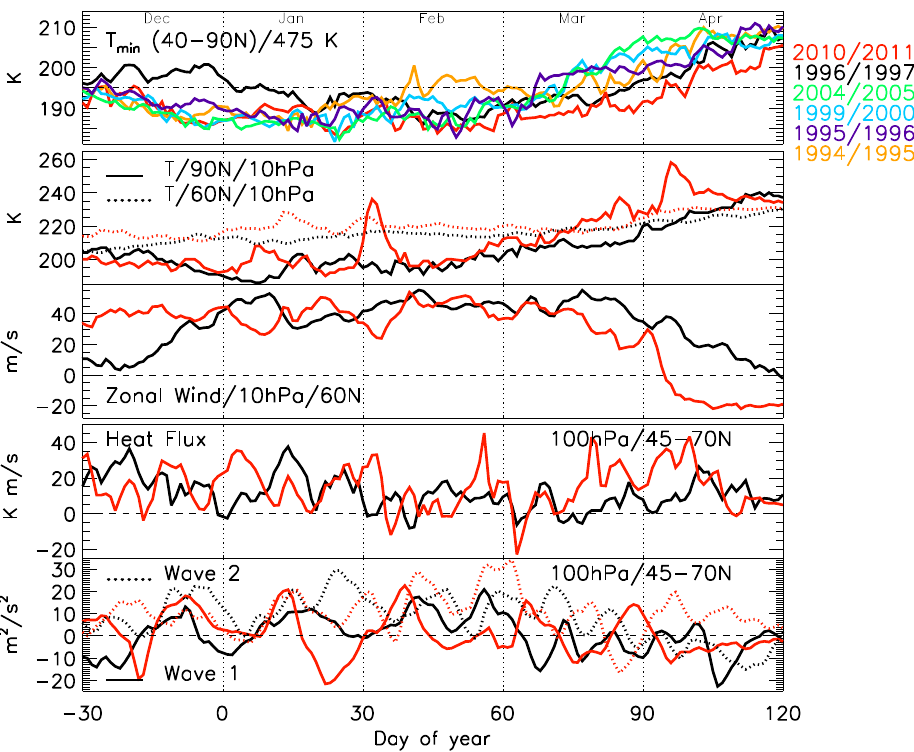
Fig. 1. Temporal evolution of minimum temperature at 475K (top plot), temperature at 60 ◦ N and 90 ◦ N at 10hPa (second plot from the top), zonal wind at 60 ◦ N/10hPa (third plot from the top), heat flux (fourth plot from the top), and planetary wave amplitudes (bottom) for the Arctic winters 1996/1997 (black) and 2010/2011 (red). The heat flux and wave amplitudes are averaged between 45 ◦ N and 70 ◦ N at 100hPa. The minimum temperatures during the cold Arctic winters 1994/1995 (yellow), 1995/1996 (violet), 1999/2000 (blue) and 2004/2005 (green) are also shown. The dash-dotted line represents 195K temperature, the dashed lines mark the zero-wind line, zero heat flux or zero wave amplitude in the respective plots, and dotted vertical lines differentiate the approximate boundaries of each month.